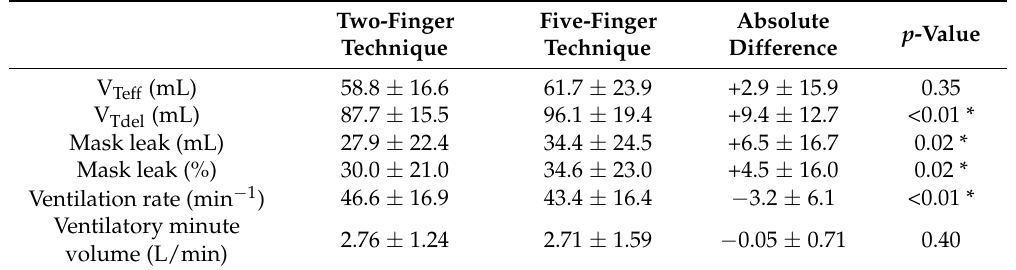
Table 1. Comparison of tidal volumes, leak, and ventilation rate between two-finger vs. five-finger techniques.